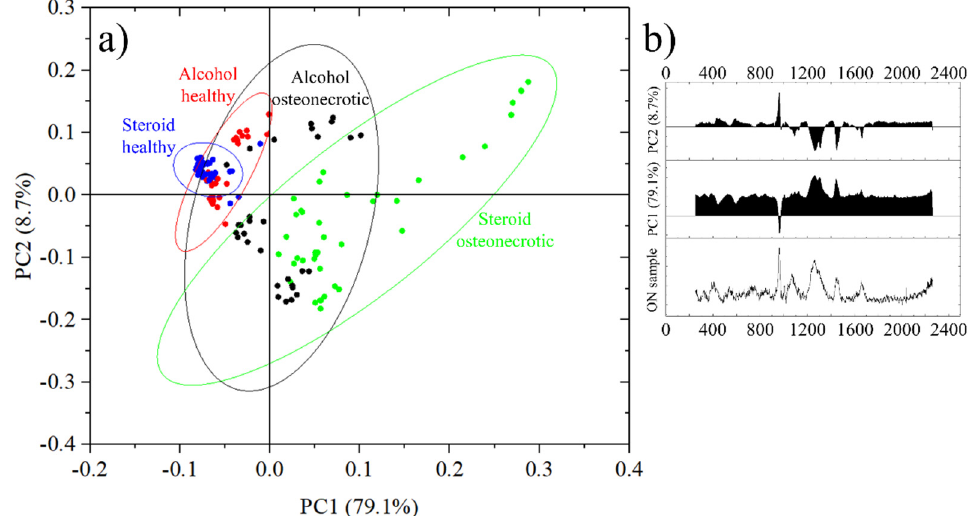
Figure 6. ( a ) Principal Components Analysis of the different samples, divided into four groups depending on the origin and health status and ( b ) Principal components PC1 and PC2 with their score and an osteonecrotic spectrum for comparison.